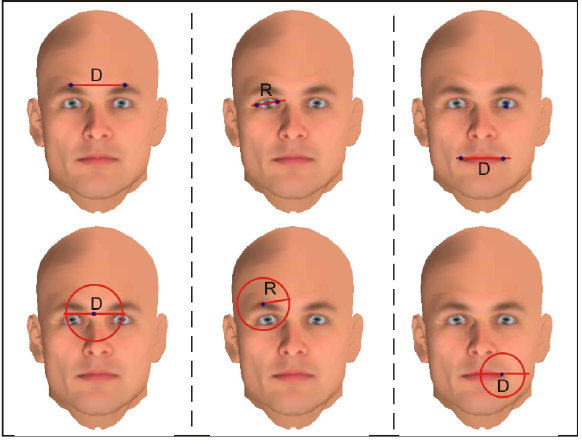
Figure 14. Definition of the radius of some spherical influence zones.